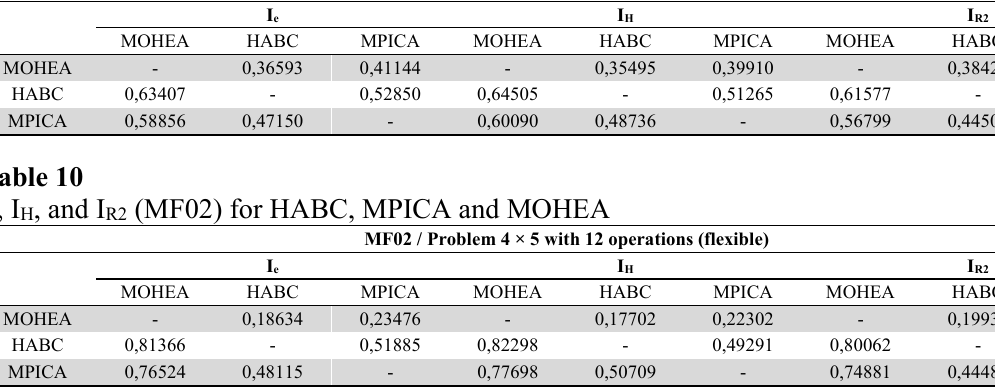
I e , I H , and I R2 (MF01) for HABC, MPICA and MOHEA MF01 / Problem 3 × 4 with 8 operations (flexible)